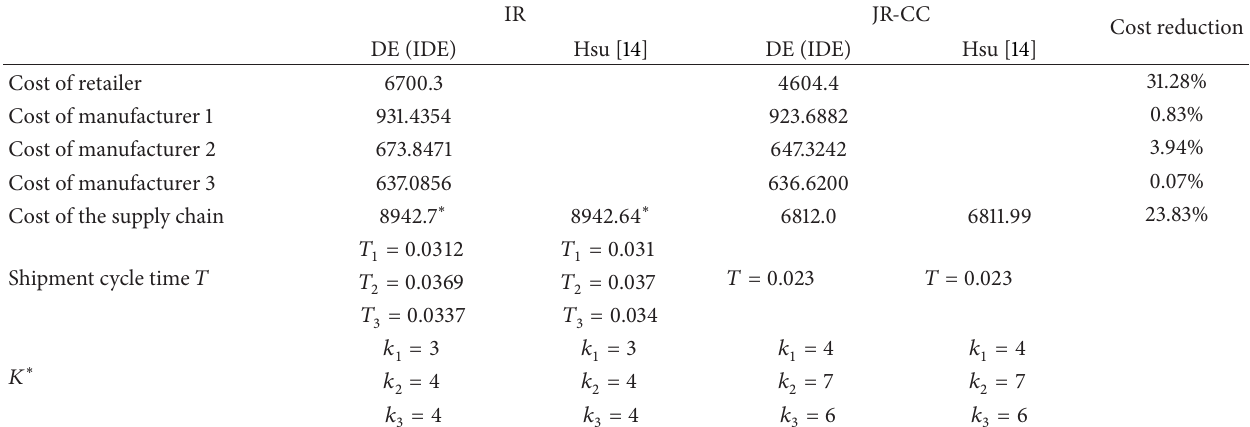
Table 5: Comparison between independent replenishment and JR-CC policy.